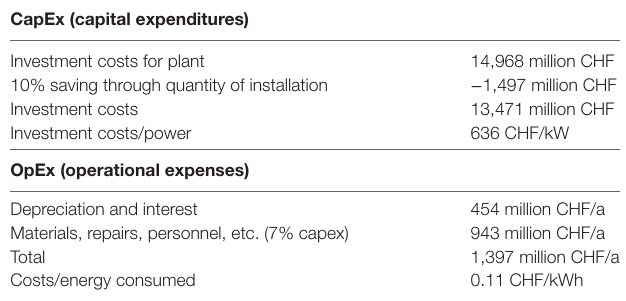
TaBle 7 | Breakdown of the costs for AEL for total plant power of 21,188